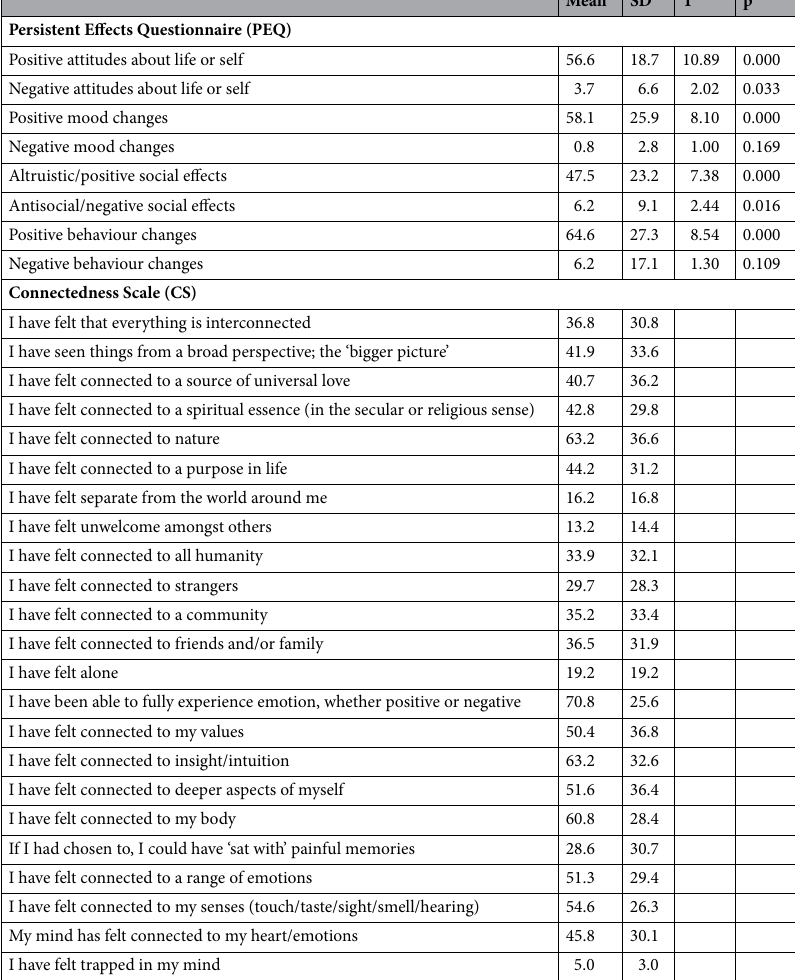
Table 3. Group level summary statistics for subacute effects. Note that data (n = 13, each for CS and PEQ) is reported in its completeness and raw significance values are reported instead of significance thresholding. For the PEQ scores we performed t-tests against zero and provide